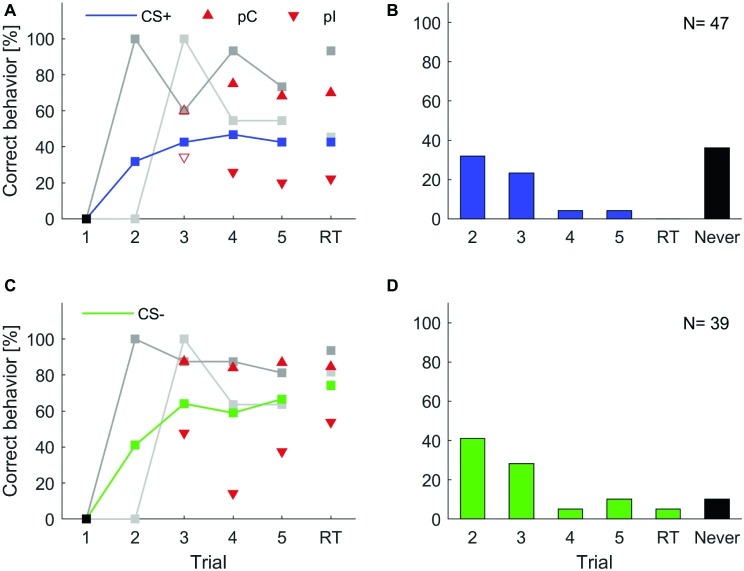
Individual learning abilities in classical olfactory conditioning. Data for isoamyl acetate as CS+ and butyric acid as CS+ were pooled, likewise data for isoamyl acetate as CS− and butyric acid as CS− were pooled. Correct learning is represented by (A) increasing responses to the rewarded odor in the case of CS+ and (C) increasing response-suppression to the punished odor in the case of CS−. (A,C) Upward pointing triangles depict animals, which correctly behaved in the respective trial and already showed a correct behavior in the previous trial (pC). Triangles pointing downward depict animals that correctly behaved in the respective trial but did not do so in the previous trial (pI). Filled triangles indicate a significant difference of subgroups in the respective trials, empty triangles represent subgroups that were not significantly different (χ2; α = 0.05). Animals behaving correctly in trial two, i.e., after a single training trial (dark gray; CS+: N = 15; CS−: N = 16) showed consistently high probabilities of correct responses in subsequent trials (cf. Pamir et al., 2014). Similarly, high response scores were observed for animals responding correctly for the first time in trial three (light gray; CS+: N = 11; CS−: N = 11). Black squares indicate the exclusion of animals that did not behave correctly in the first trial. (B,D) Proportion of animals behaving correctly for the first time in the indicated trial. A high percentage of animals expressed a correct behavior already after a single training trial. A substantial proportion of animals never behaved correctly (black bars).